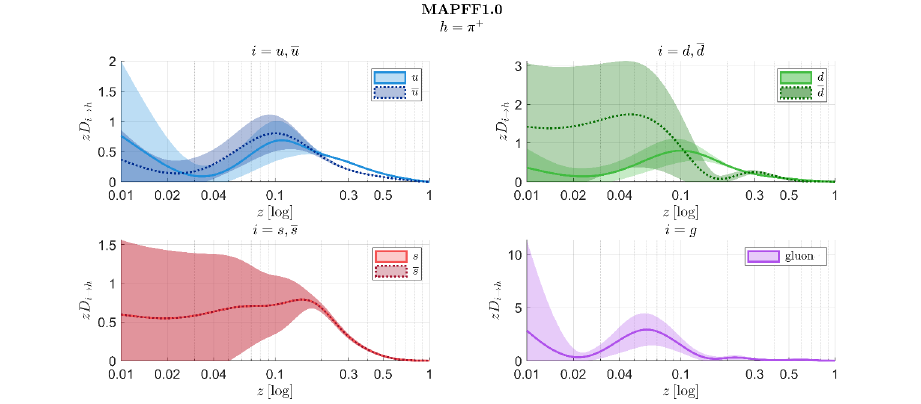
Figure 3. Fragmentation function of various partons to an identified pion, with uncertainty bands.